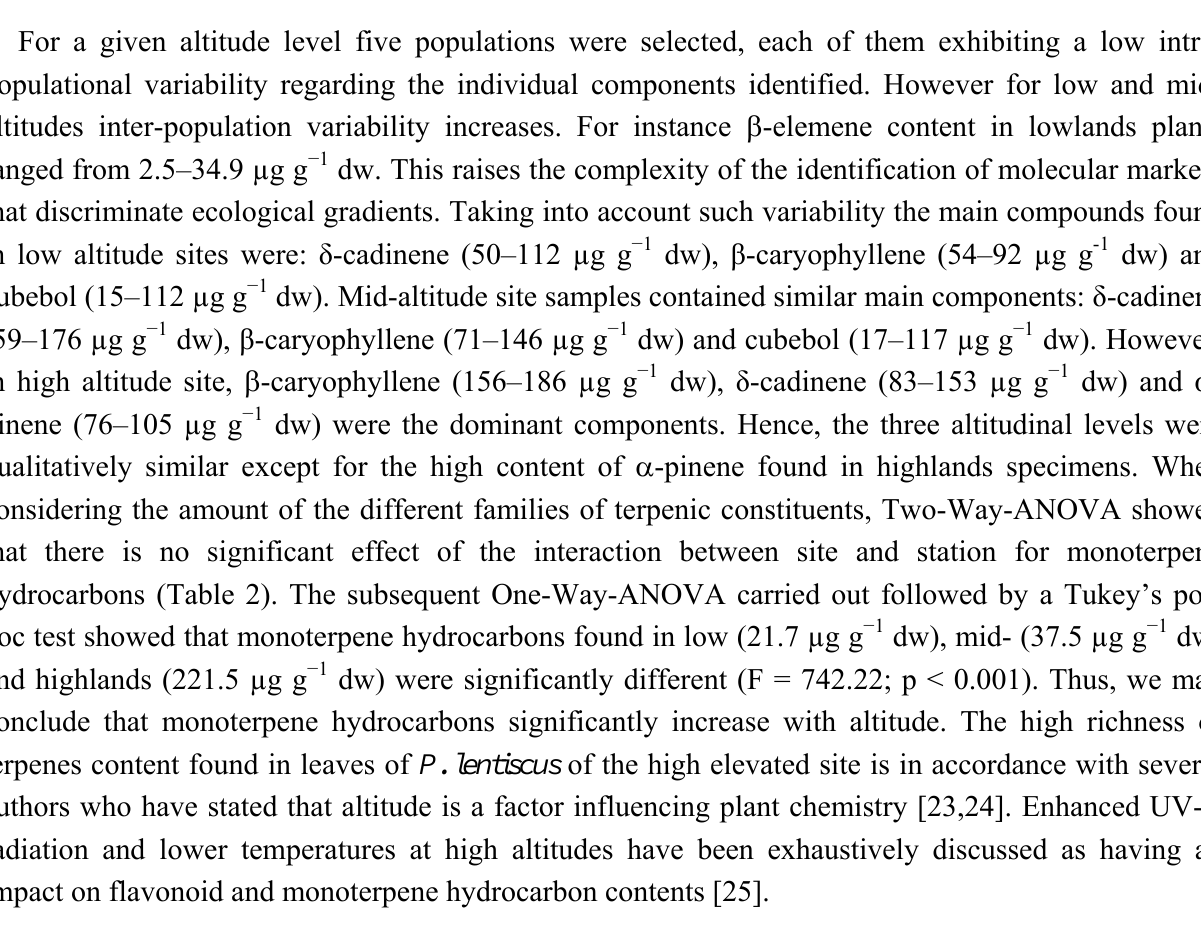
Table 2. Variance analysis (Two-Way Anova test, 5%) of monoterpenes (hydrocarbons and oxygenated), sesquiterpenes (hydrocarbons and oxygenated) and total terpenes between sites, stations and interaction site vs